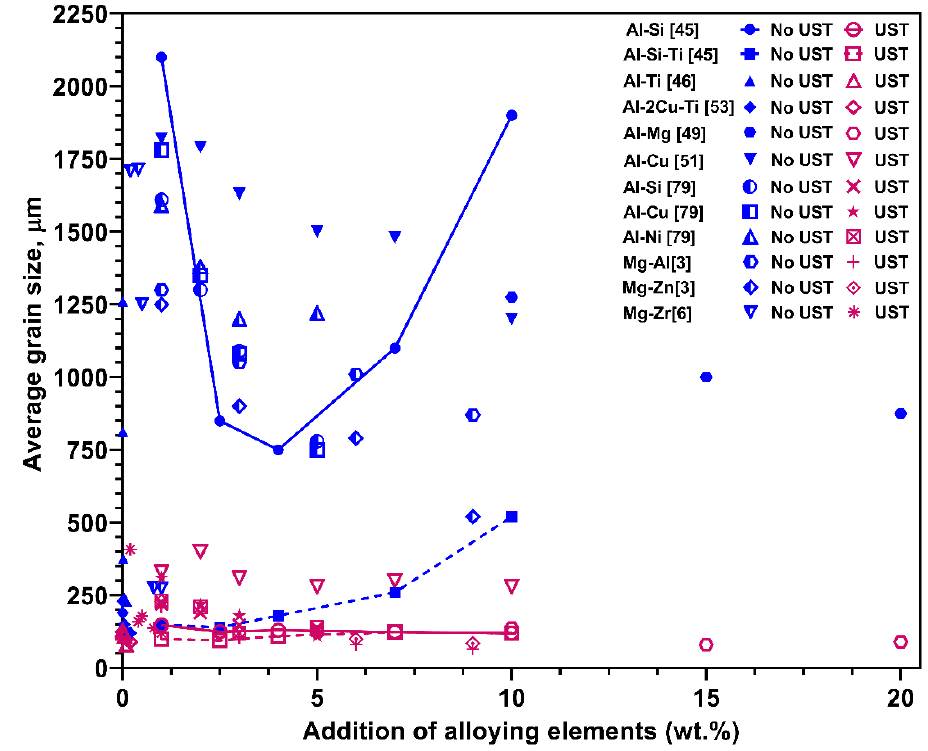
Figure 16. Role of alloying elements on the grain refinement achieved when UST is applied during continuous cooling from above to below the liquidus temperature.